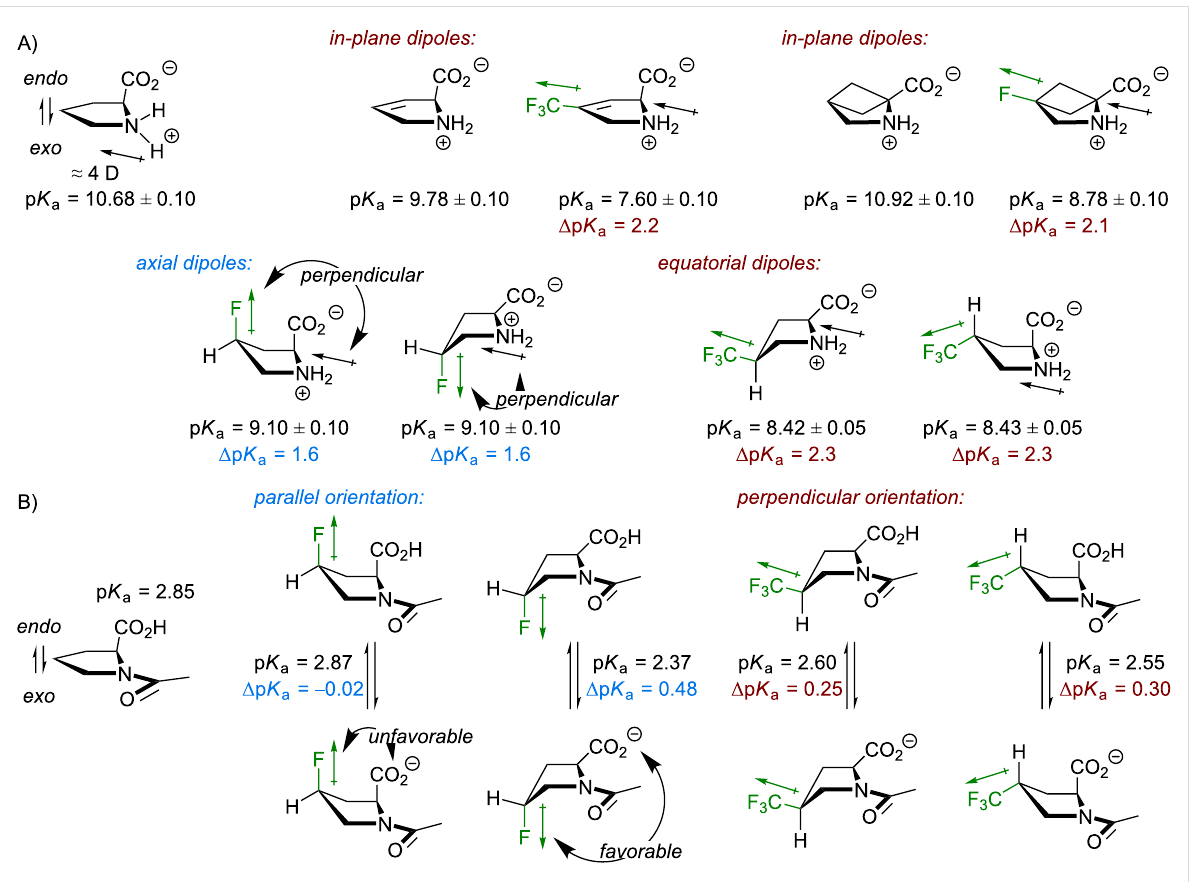
Figure 6: A) The basicity reduction from the introduction of the dipoles reflects the preferred conformation of the side chains. The positive end of the ammonium dipole is on the hydrogen atoms attached to the nitrogen. The nitrogen atom is the negative end. B) The acidity of the carboxylic group depends on the relative orientation of the substituent dipole with respect to the charged carboxylate. Only the s- cis rotamer data is shown. The error is ±0.05.